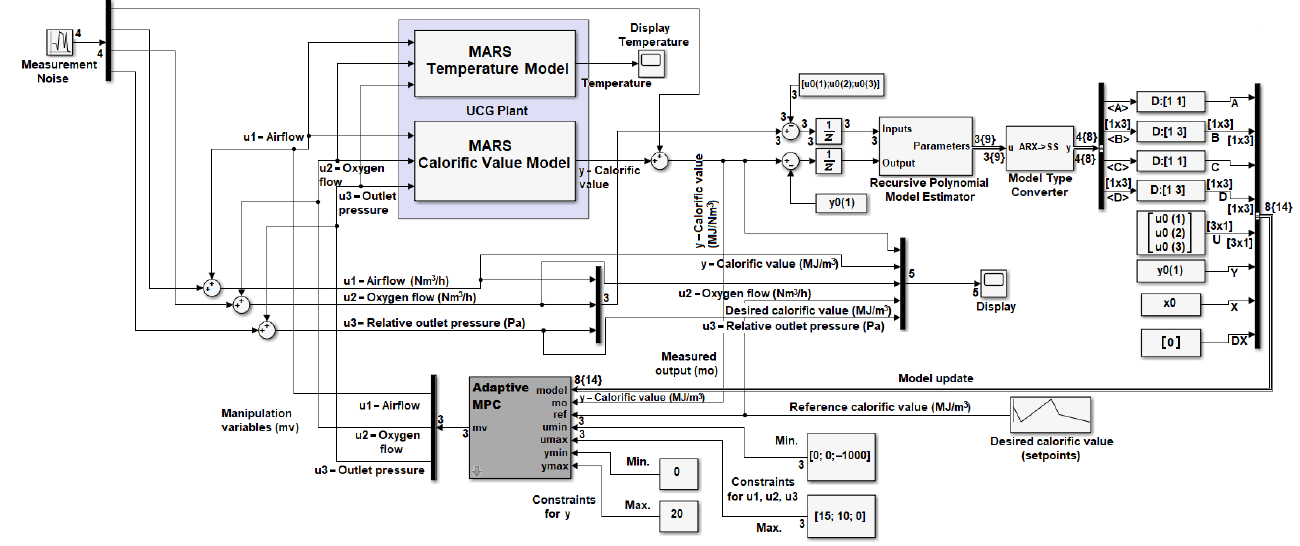
Figure 26. Simulation model of MPC [41].